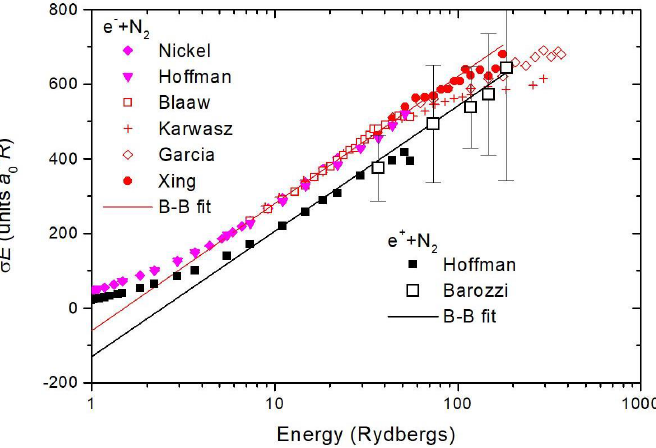
Figure 6. High-energy total cross sections for electron and positron scattering on N 2 . The lines are the Bethe-Born fit, Equation (4). For references for electron scattering see the review [43]; for positrons Detroit [74] and Trento data [75] are used.